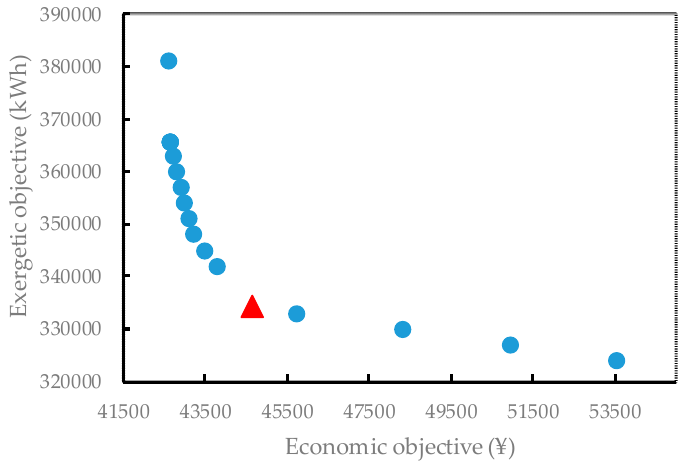
Figure 3. Pareto front of single- period for SSS. Table 9. Optimal scheduling results of boilers load for SSS.